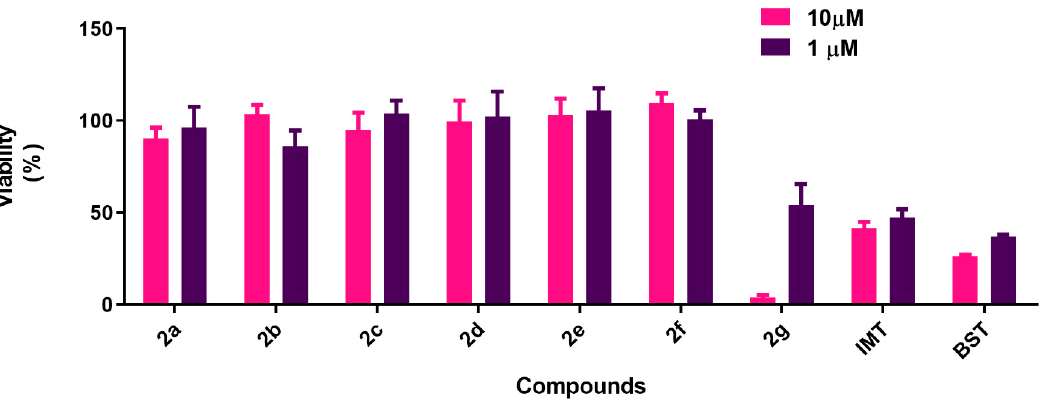
Figure 4. Screening of BST, IMT, and its derivatives 2a – g , 3a – b , and 4a – b at concentrations of 1 µM (in red) and 10 µM (in blue) against the human cell line K562.